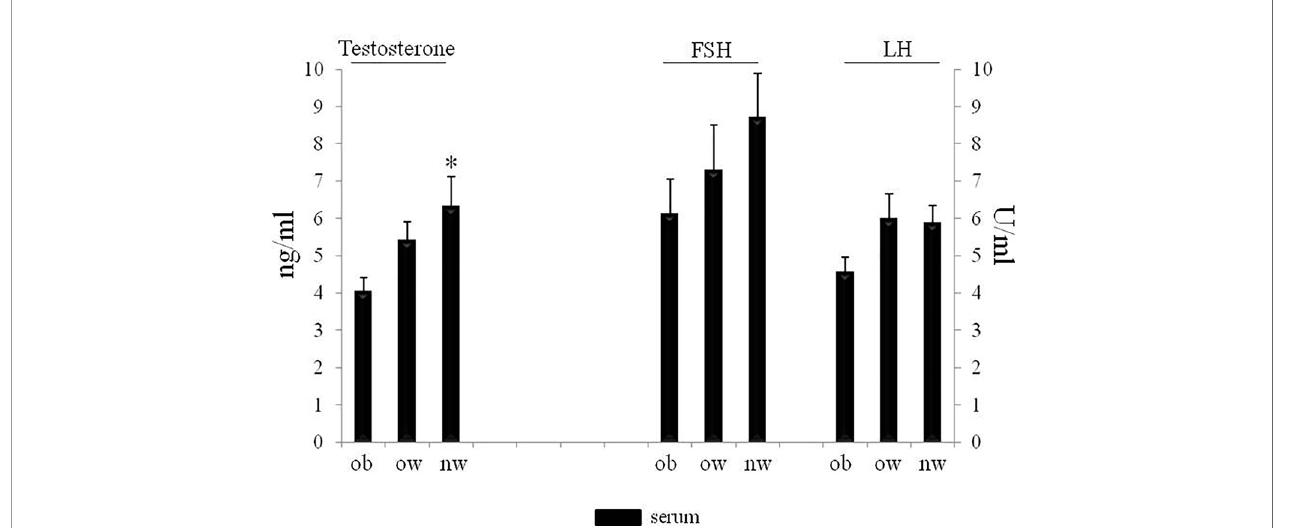
FIGURE 3 | Serum of obese, over and normal weight subjects were analyzed for testosterone, FSH and LH amount. Testosterone is expressed as ng/ml; FSH and LH are expressed as U/ml. Data are presented as the means ± SE. Statistical signi fi cance was determined using ANOVA with Bonferroni ’ s post-hoc test. * P < 0.05 vs . obese subjects. ob, obese; ow, over-weight; nw, normal weight; FSH, follicle-stimulating hormone; LH, Luteinizing